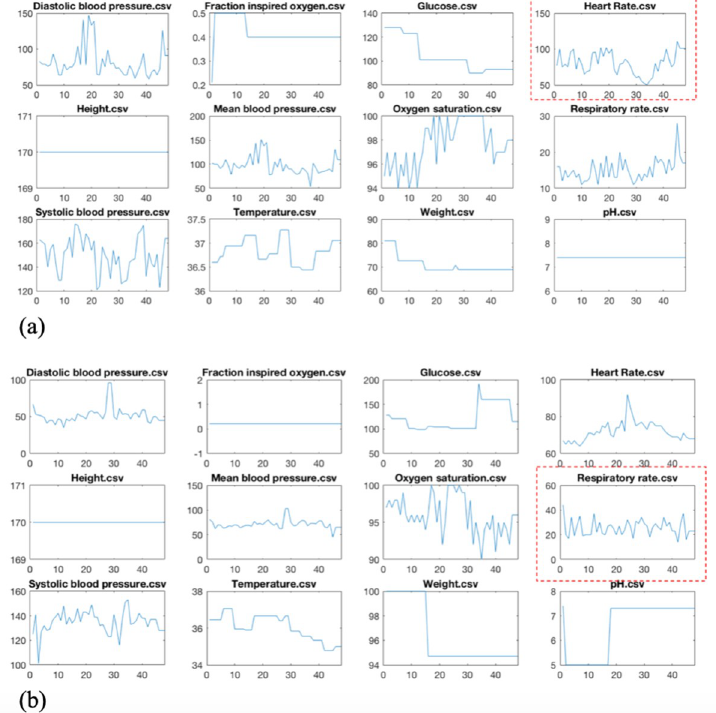
the traditional models. In both cases, the abnormal sequence has oscillated around the normal value of the chart event, which in return a linear model would regress it to a normal value with a negligible slope. Effectively, our LSTM-CNN is capable of capturing such high volatile behavior, a common pattern among high-risk ICU patients with unstable